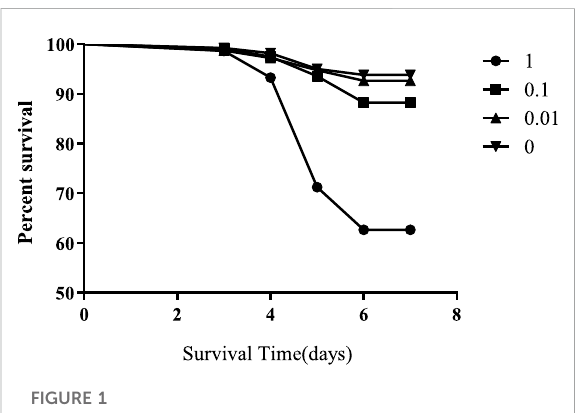
Effect of fl umethrin on the survival of honeybee